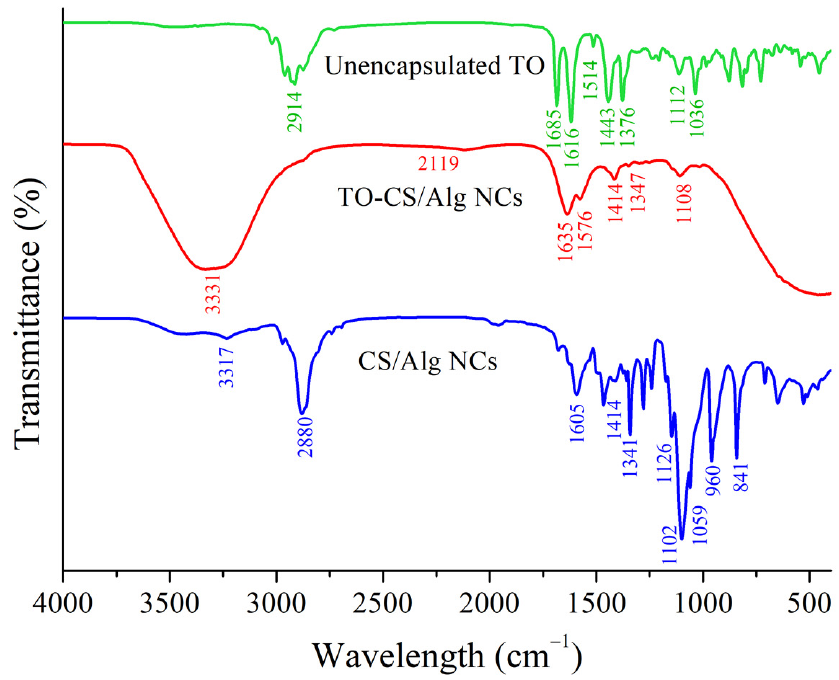
Figure 3. Fourier transform infrared spectra of unencapsulated TO, TO-CS/Alg-NCs, and CS/Alg- NCs.